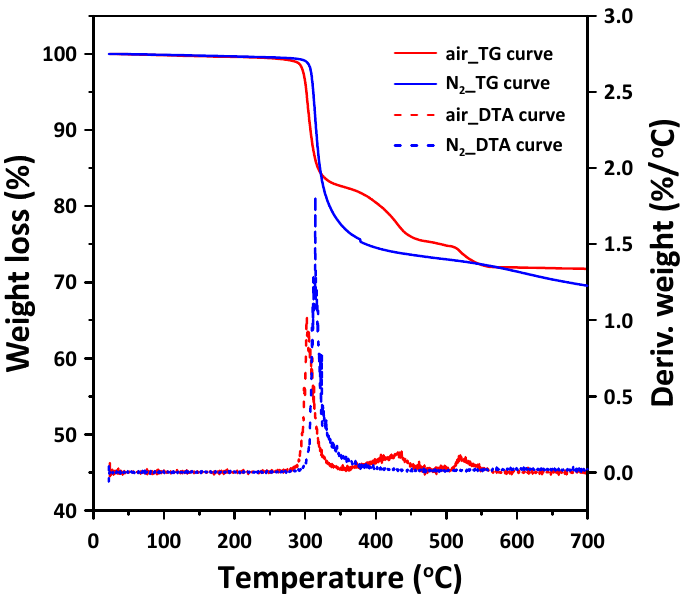
Figure 3. TGA-DTA curves of the PCBs according to the nitrogen and air conditions. Solid lines represent the TGA curve and dotted lines represent the DTA curve .